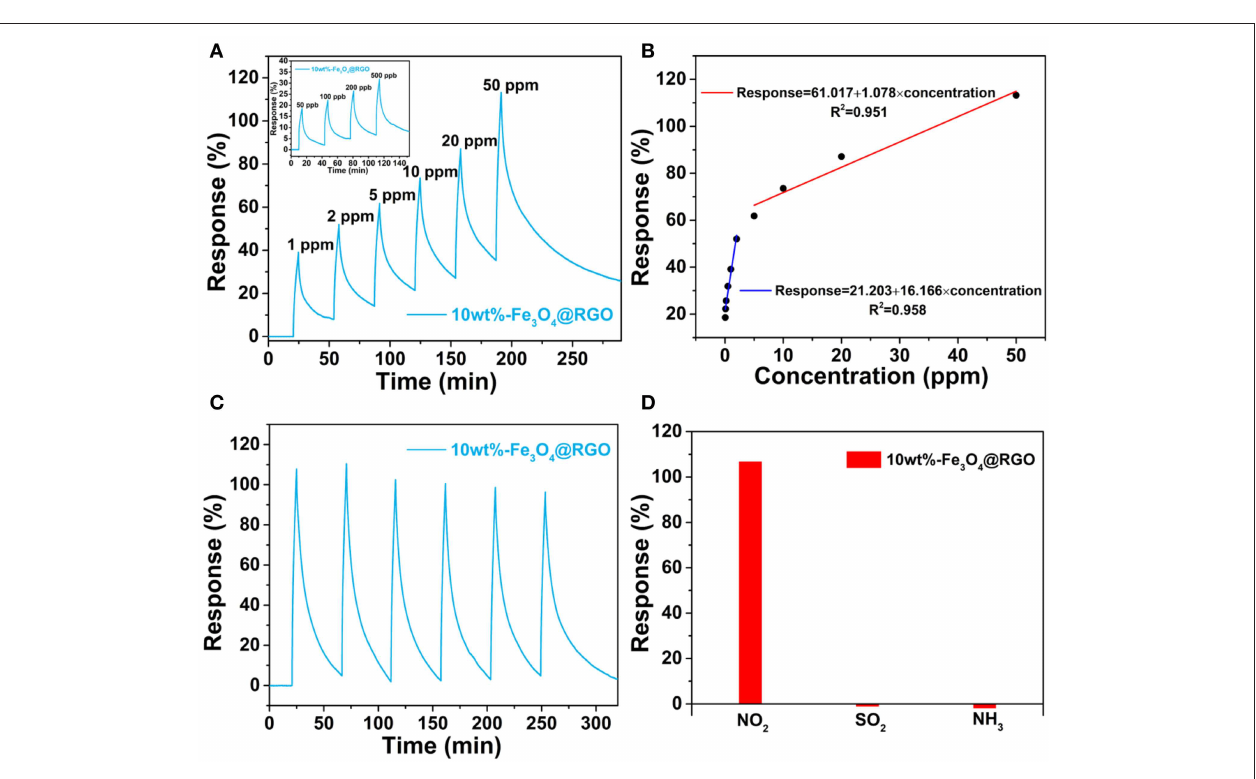
FIGURE 7 | (A) Dynamic curves of 10wt%-Fe 3 O 4 @RGO to different NO 2 concentrations. (B) Response variation of the 10wt%-Fe 3 O 4 @RGO sensor as a function of NO 2 concentration. (C) Six successive sensing cycles of 10wt%-Fe 3 O 4 @RGO to 50 ppm NO 2 . (D) Selectivity of the as-fabricated sensor upon exposure to 50 ppm NO 2 , SO 2 and NH 3